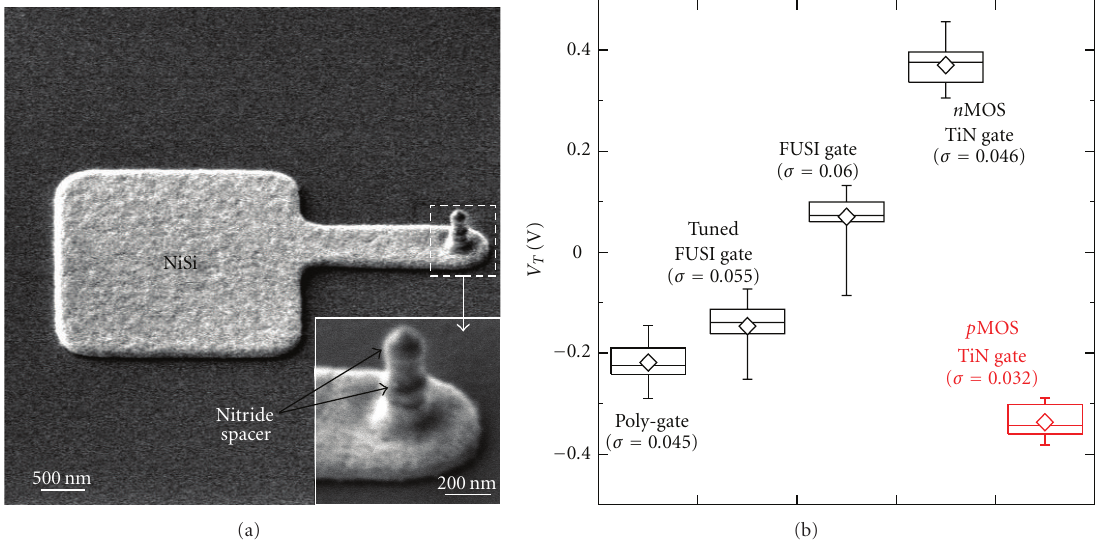
Figure 5: (a) A scanning electron microscope (SEM) image of an FUSI gate device after silicidation (440 ◦ C, 30s) and removal of un- reacted Ni in H 2 SO 4 :H 2 O 2 :H 2 O solution. (b) Box plots of the V th distribution of measured devices for each split. V th extraction using linear extrapolation was done for over 10 devices in each